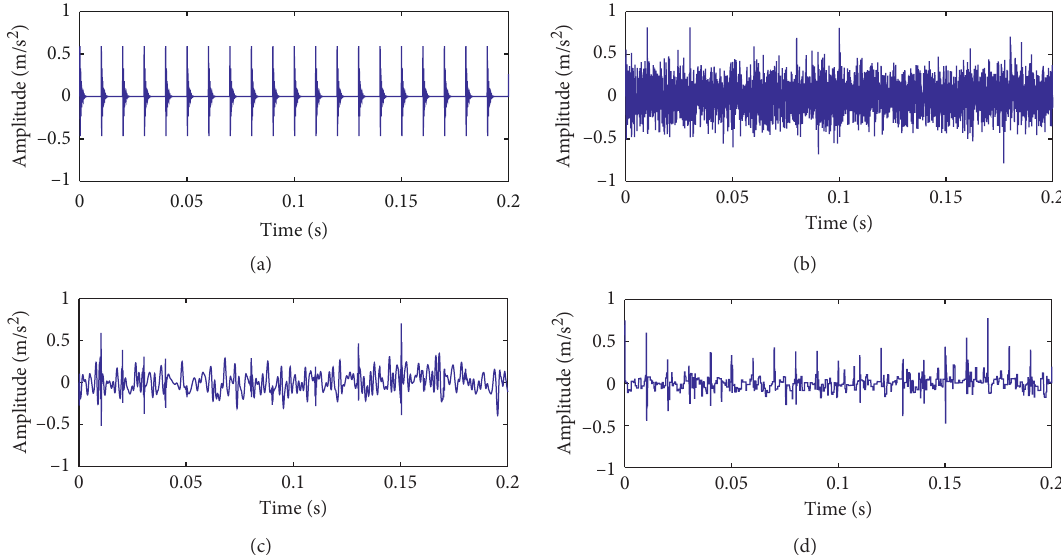
Figure 5: (a) The original signal, (b) signal with Gaussian noise, (c) the waveform of a purified signal with wavelet threshold denoising, and (d) the waveform of the purified signal using